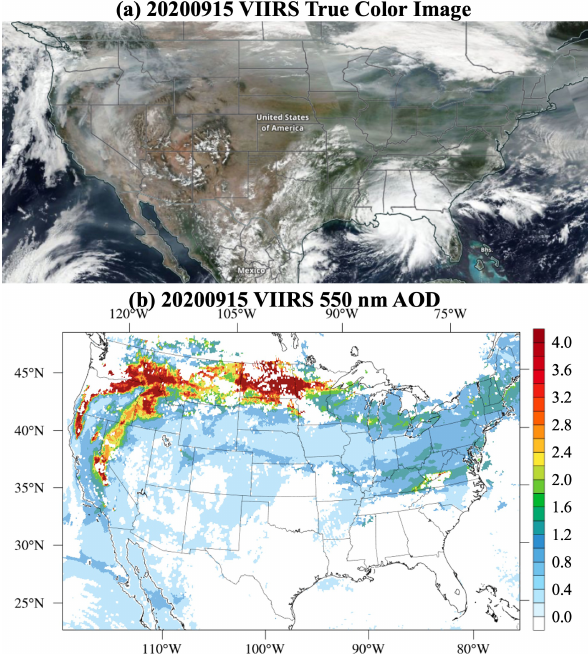
Figure 1. Observations of wildfire smoke on 15 September 2020, over the continental United States by the Visible Infrared Imag- ing Radiometer Suite (VIIRS) aboard the Suomi National Polar- orbiting Partnership (Suomi NPP) satellite. (a) True-color image and (b) 550nm aerosol optical depth